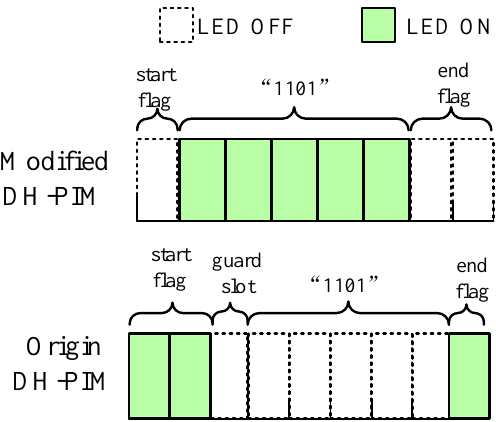
Figure 5. Comparison before and after modification of DH-PIM.